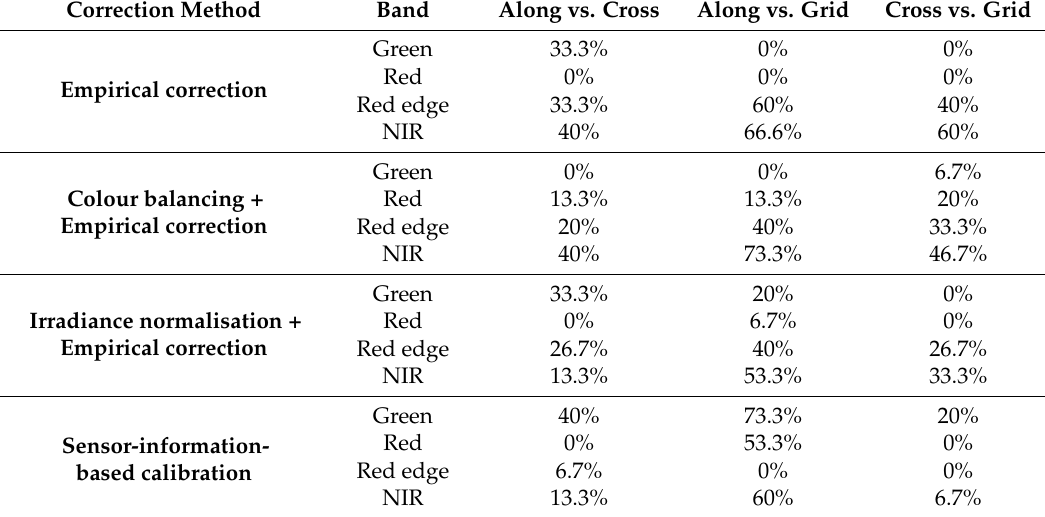
Table A4. Reflectance consistency percentages of ground areas between different flight patterns in dataset 1.